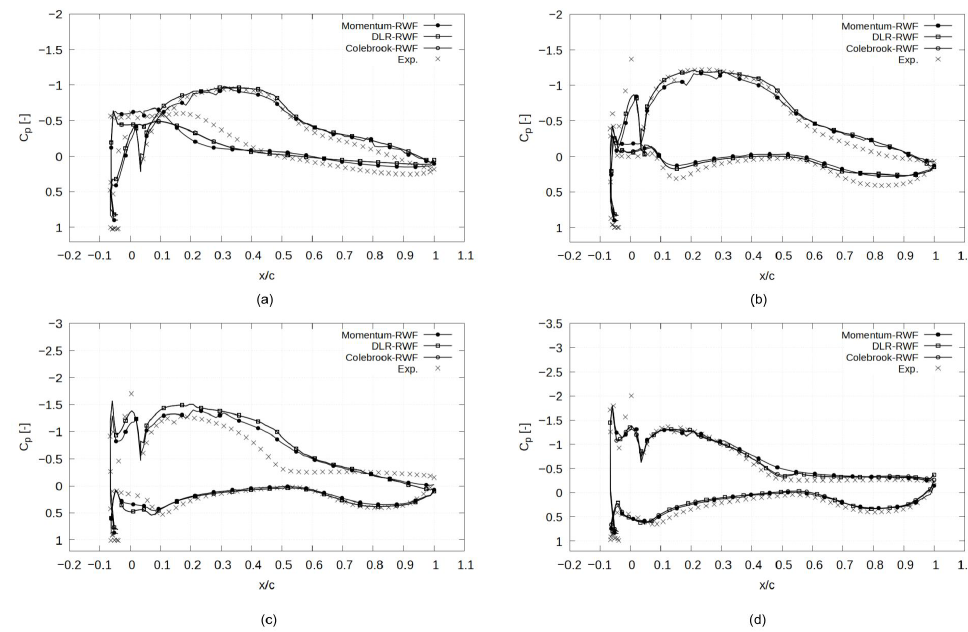
Figure 14. Case 3: C p distribution for AoA = ( a ) 0 ◦ , ( b ) 4 ◦ , ( c ) 8 ◦ , and ( d ) 12 ◦